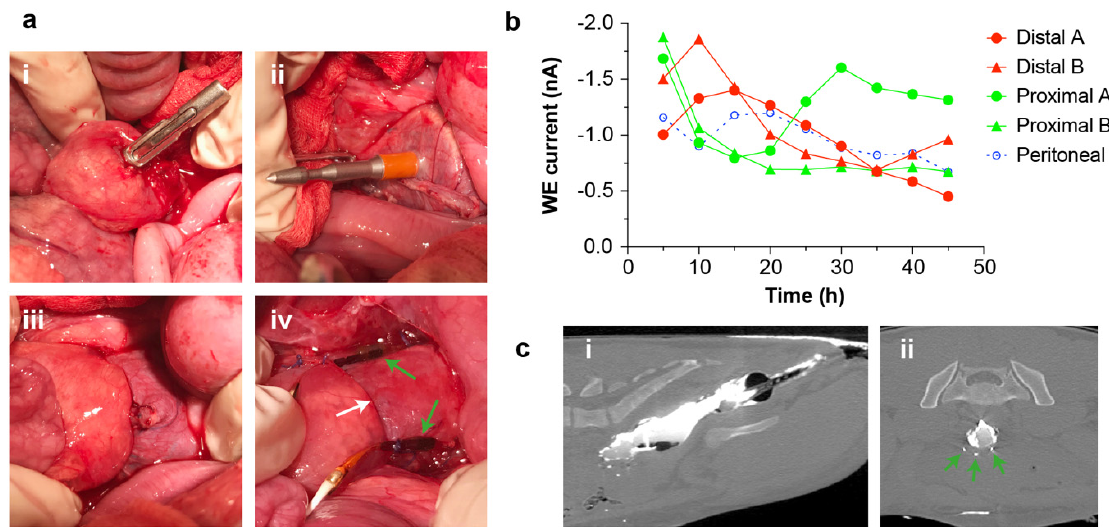
Figure 4. Continuous colorectal anastomosis monitoring. ( a ): Intra-operative photographs showing creation of a stapled colorectal anastomosis and sensor placement. ( i ) Proximal colon with stapler anvil secured by a purse-string suture; ( ii ) distal colon with transverse staple line and stapler spike protruding at the midpoint; ( iii ) proximal and distal colon joined by closure and firing of the stapler; ( iv ) placement of distal sensors (green arrows) at the anastomosis (white arrow). ( b ): Mean steady-state current from each sensor during the 45 h experiment, averaged over 5 h periods (five sensors, from one pig). ( c ): Post-mortem positive contrast CT images taken following a colorectal resection and anastomosis. ( i ) Transverse view. The positive contrast agent (Gastrografin) can be seen filling the rectum and distal colon. The contrast agent ran past the anastomotic site with no evidence of leakage of contrast material outside the intestinal lumen. ( ii ) Sagittal view. This image was taken through the anastomotic site. Three sensors can be identified surrounding the colon (green arrows). There is no evidence of leakage of contrast material outside the intestinal lumen.